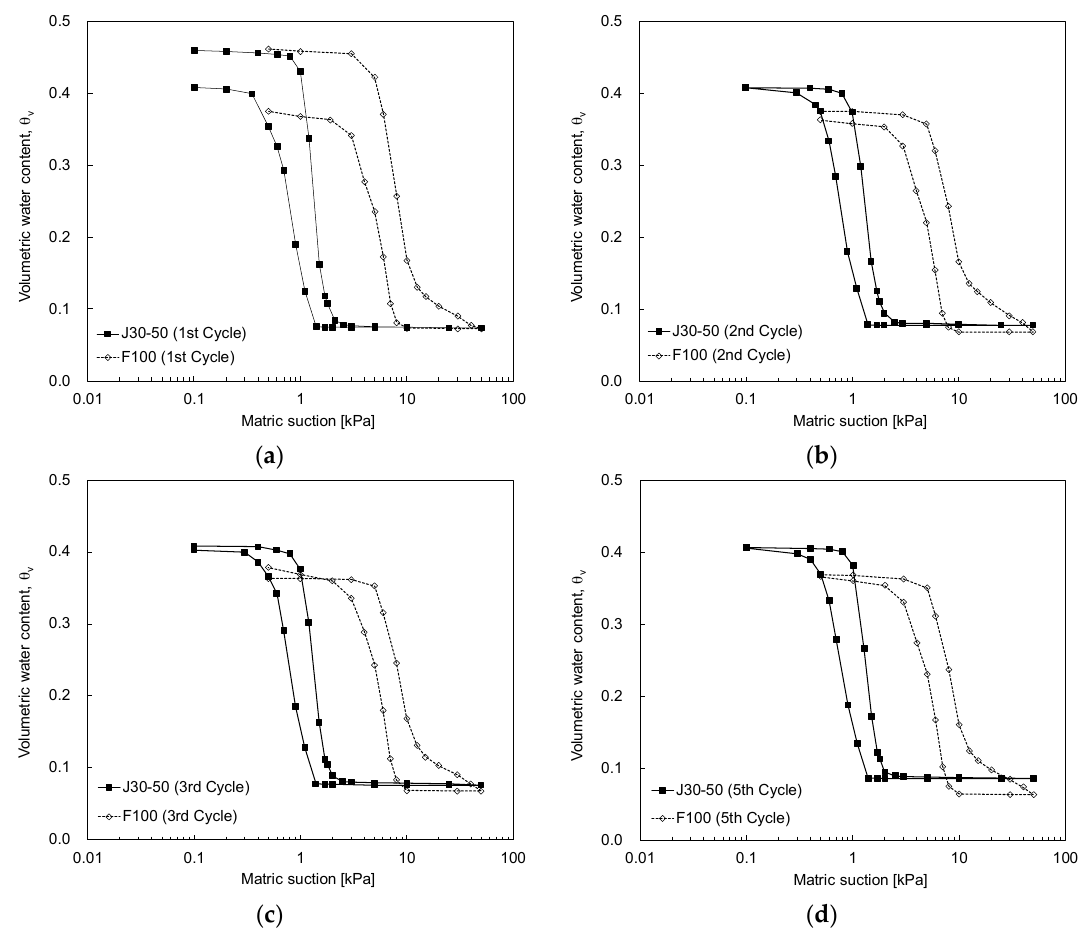
Figure 12. SWCC according to the particle size: ( a ) first cycle; ( b ) second cycle; ( c ) third cycle; ( d ) fifth cycle.